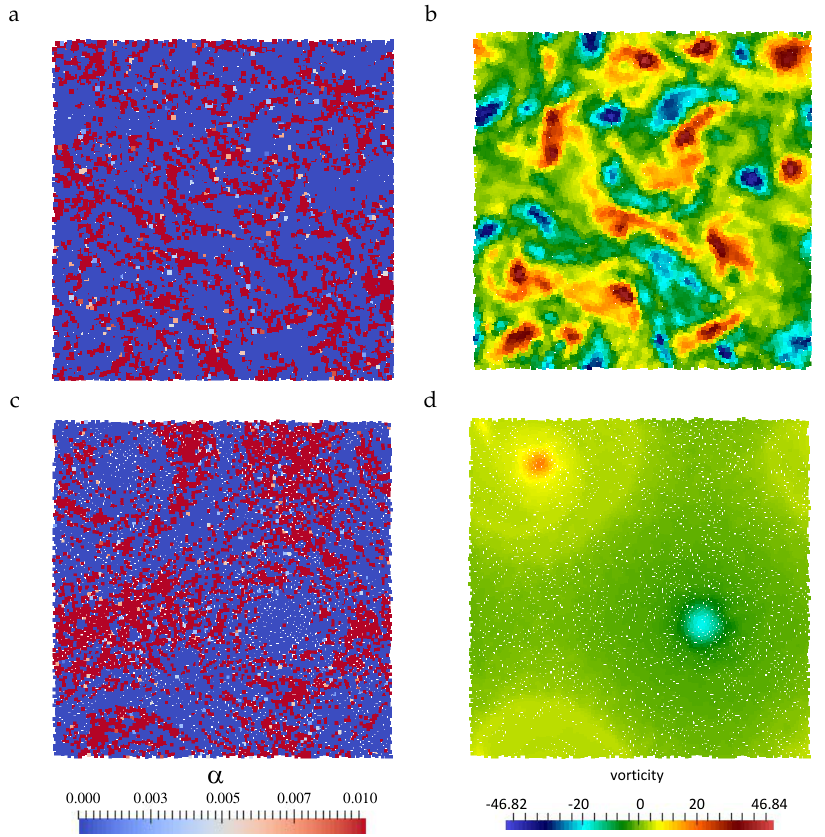
Figure 4. Inviscid two-dimensional Taylor–Green flow. On the left, value of (cid:101) given by Equation (17). On the right, vorticity field. Figures ( a , c ) show the results at t = 2 and figures ( b , d ) show the results obtained at t = 25, using a resolution of 10,000